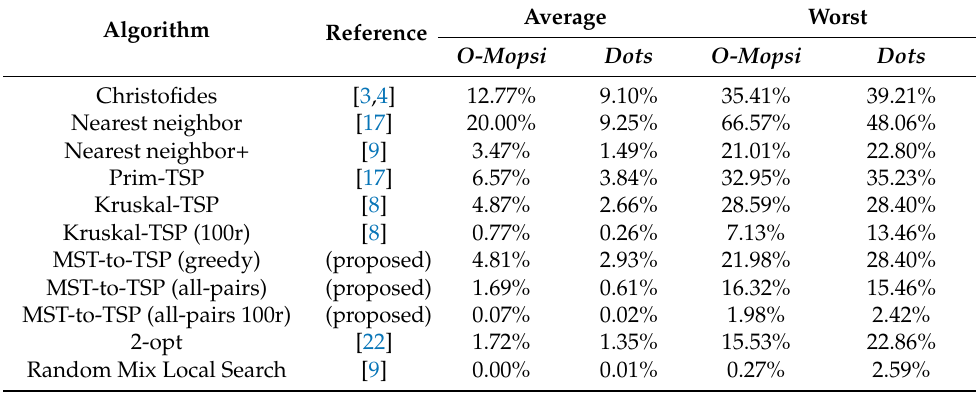
Table 2. Accuracy comparison of the algorithms (gap) for the two series of